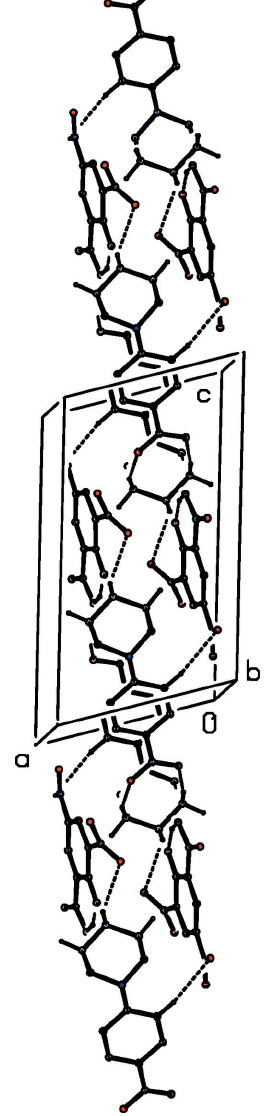
Figure 8 Part of the crystal structure of compound (II) showing the formation of a chain of hydrogen-bonded rings running parallel to the [001] direction. Hydrogen bonds are drawn as dashed lines and, for the sake of clarity, the H atoms bonded to those C atoms that are not involved in the motif shown have been